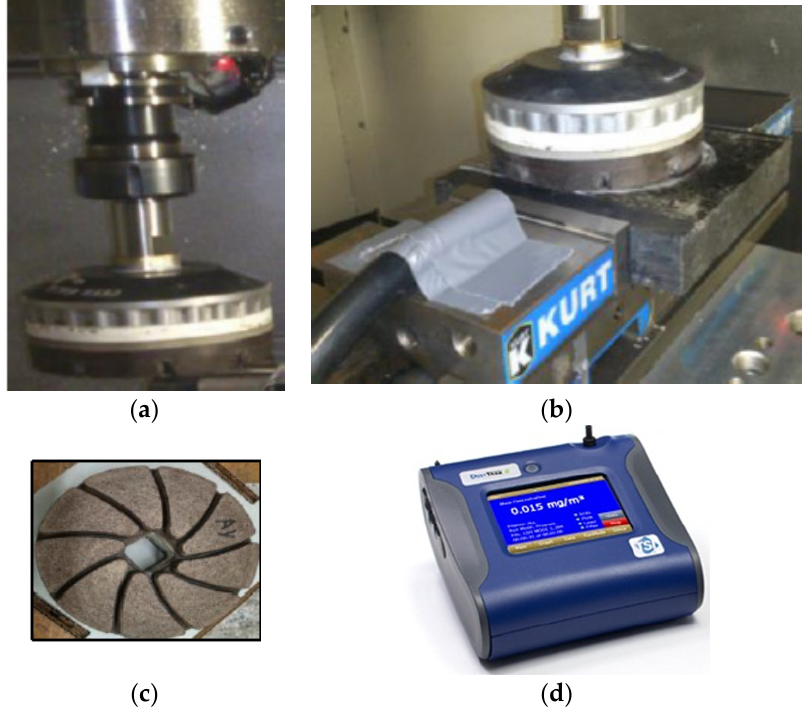
Figure 2. Experimental setup and equipment used in the present study (Saidi et al. (2018) [22]). ( a ) Polishing tool; ( b ) Particle sampling position; ( c ) Abrasive tool geometry; ( d ) DustTrak Monitor for particle collection.